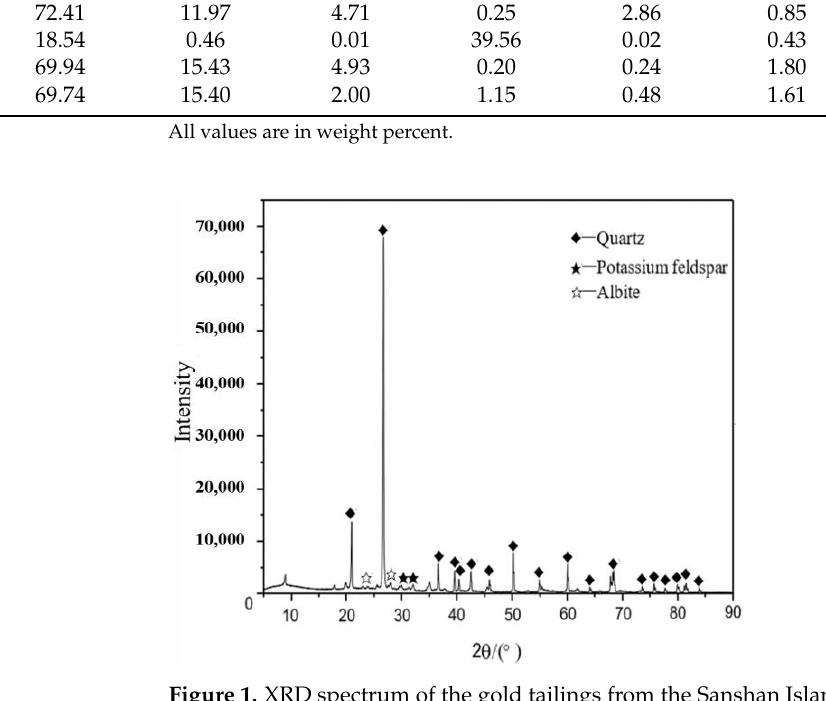
Figure 1. XRD spectrum of the gold tailings from the Sanshan Island Gold Mine. Table 1. Material composition of the foam ceramic samples.